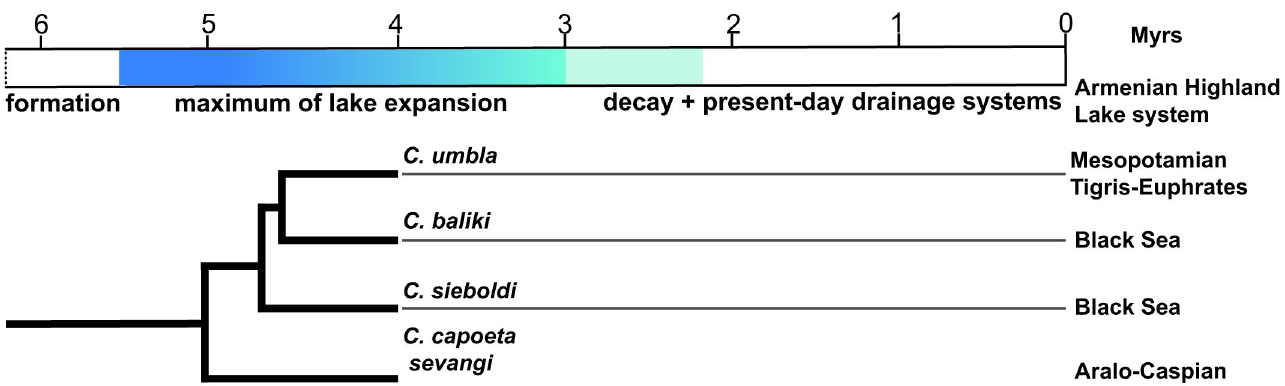
Fig 8. Hypothetical evolutionary stages of the palaeolake system of Armenian Highland since latest Miocene. Three main stages are suggested (marked by blueish colours): formation, maximum of lake expansion, decay and fully development of present-day drainage system. The monophyletic clade of recorded species within the fossil material shows the presence of the species flock of Capoeta at 4 Ma ago in palaeolake system of Armenian Highland.